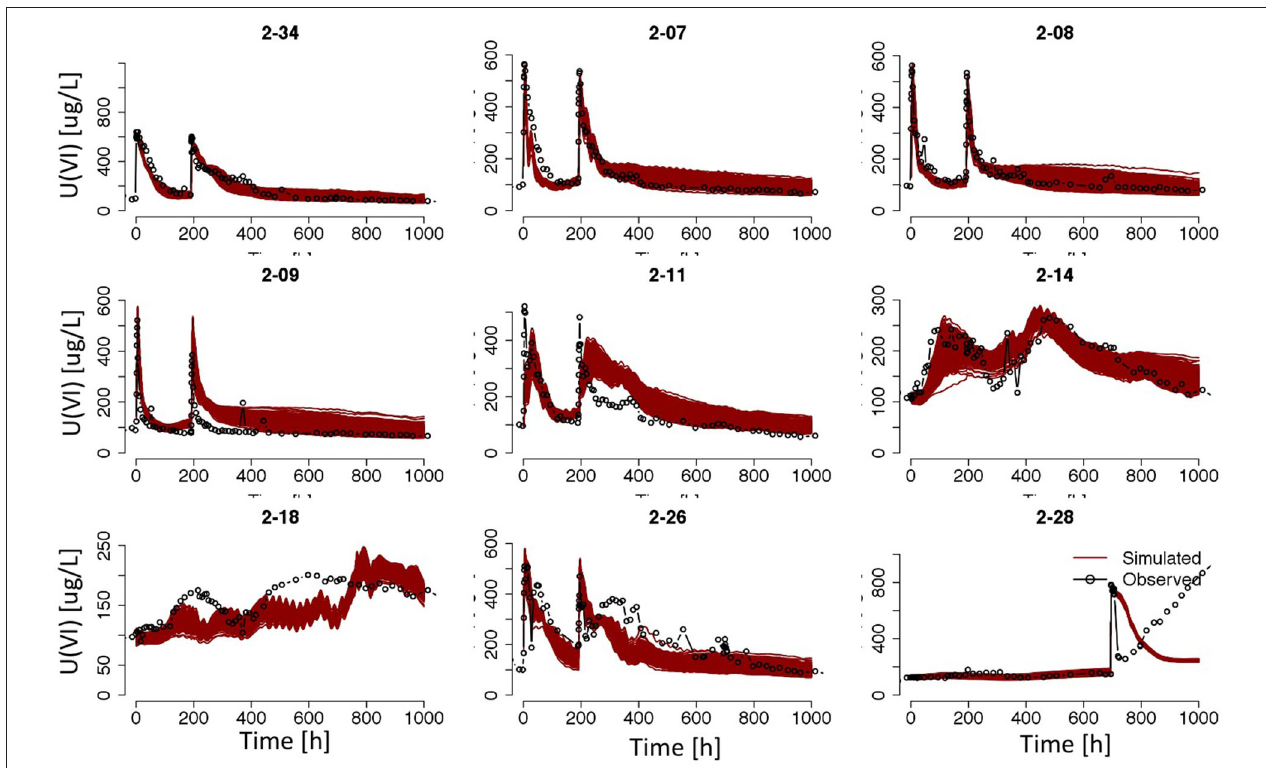
FIGURE 10 | Ensemble of predicted uranium breakthrough curves in selected wells after scaling the sorption site concentration by a factor of one-tenth and raising the pH at the northern and western boundaries from 7.5 to 8.12. Other plotting specifics are same as Figure 8